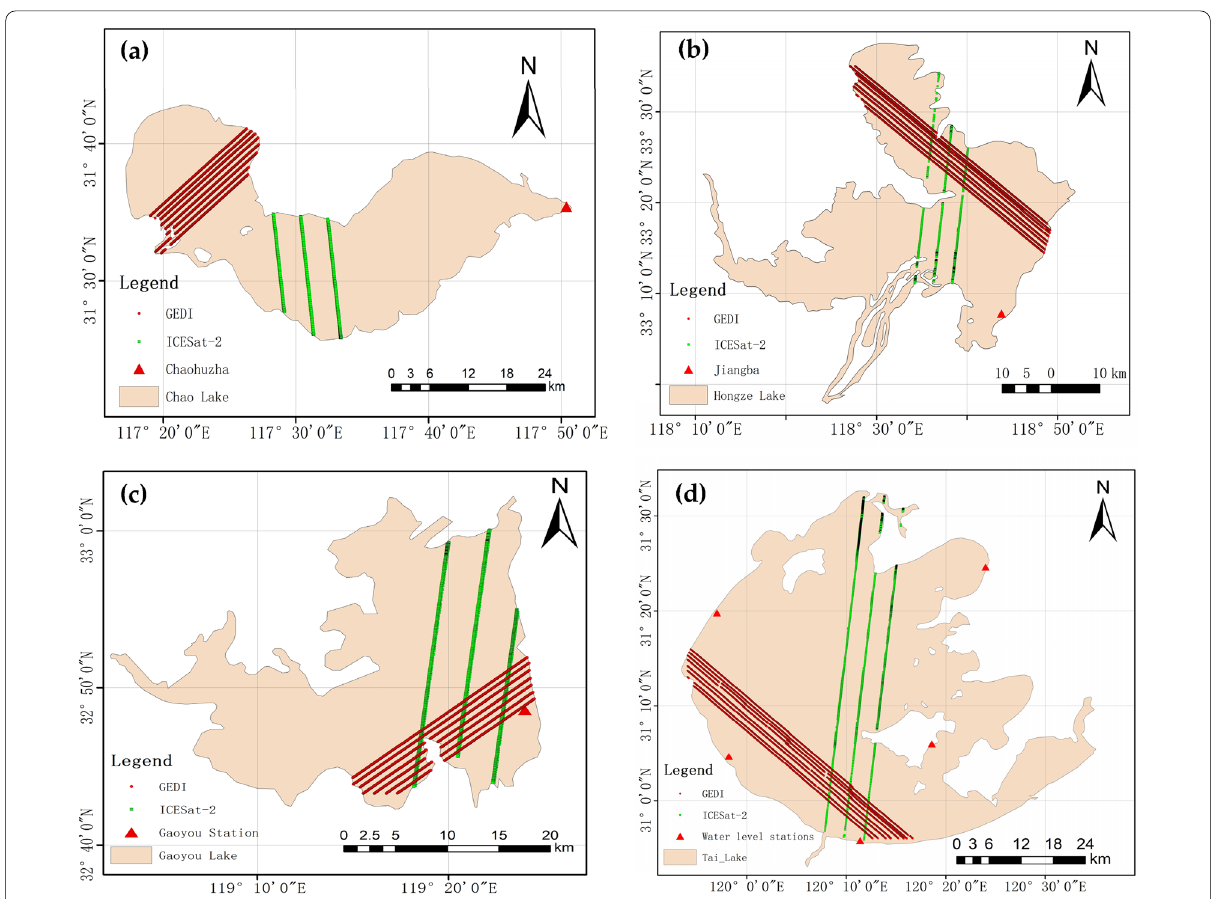
Fig. 1 Samples of ICESat-2 and GEDI over the four lakes and their hydrological stations: a Chaohu Lake (8 November 2020 for ICESat-2; 3 May 2020 for GEDI); b Hongze Lake (8 March 2019 for ICESat-2; 20 July 2020 for GEDI); c Gaoyou Lake (23 December 2018 for ICESat-2; 2 December 2019 for GEDI); d Taihu Lake (18 April 2019 for ICESat-2; 5 July 2020 for